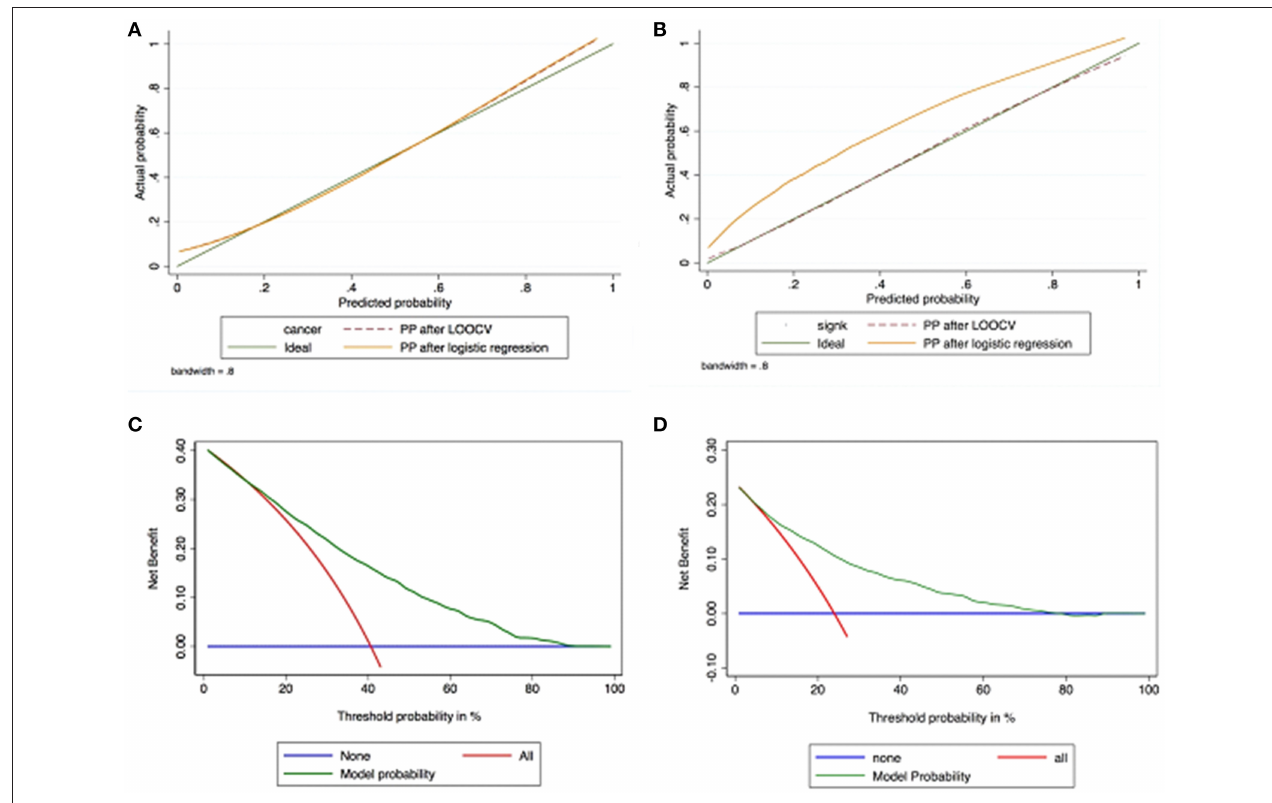
FIGURE 3 | Calibration plot of observed vs. predicted probabilityof PCa (A) and CSPCa (B) after leave-one-out cross validation, demonstrating excellent concordance. Decision curve analyses demonstrating net benefit between the threshold probabilities of ∼ 15 and ∼ 80% for the model predicting PCa (C) and between the threshold probabilities of ∼ 10 and ∼ 60% for the model predicting CSPCA (D)